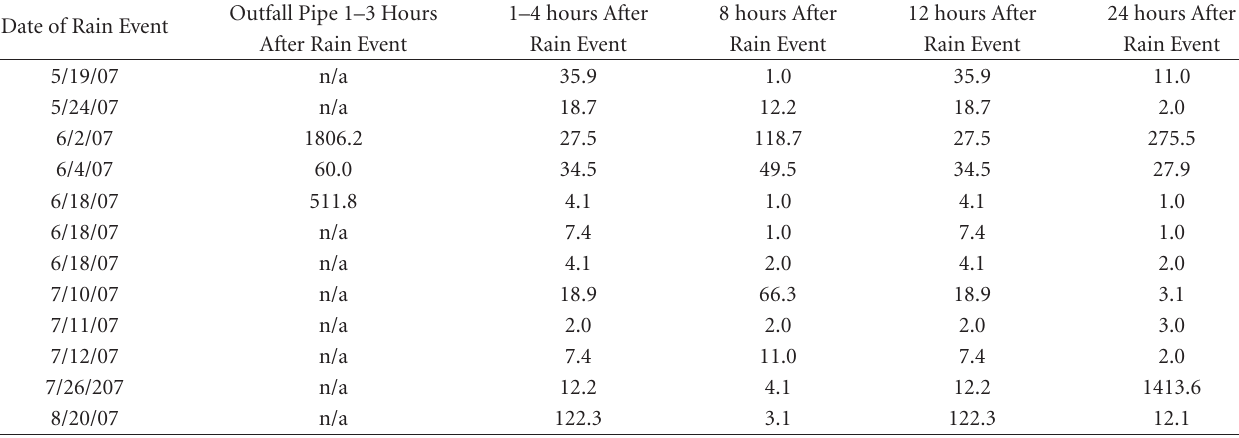
Table 3: E. coli concentrations ( ∗ MPN/100mL) from beach water collected at time intervals following the triggering of a rain event at Egg Harbor beach. There was no significant di ff erent between overall E. coli concentrations during a rain event and the seasonal mean E. coli concentrations for this beach using ANOVA (Table 1). Likewise, using Sche ff e matrix analysis, there was no significant di ff erence between E. coli concentrations at any sampling times after a rain event and the seasonal E. coli mean. If rainfall was su ffi cient to trigger multiple rain event notifications on one day, then multiple events were